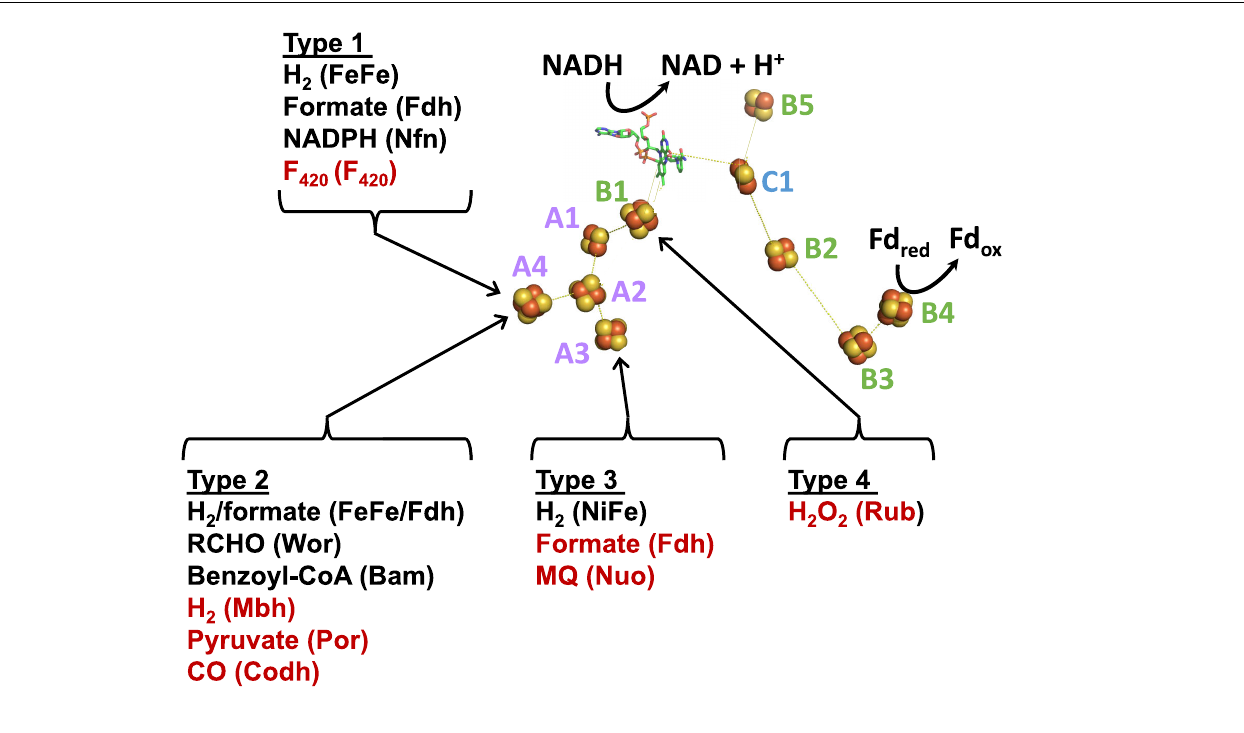
FIGURE 5 | A model of the minimum cofactor content and the predicted electron transfer pathways in characterized and uncharacterized Bfu enzymes. Characterized and predicted enzymes and their microbial sources are shown in black and red font, respectively. Electron donor sites for the Type 1–Type 4 Bfu enzymes in the BfuA subunit are based on the cofactor contents of the A subunits (see Figure 4 ). The cofactors in the BfuB and BfuC subunits are conserved in all Bfu complexes while there is variation in the cluster content in BfuA although all contain the A1 and A2 clusters. See text for abbreviations.